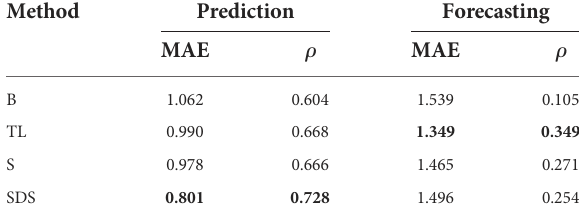
using the four methods: (B)aseline-GRU without personalisation, (T) ransfer (L)earning, (S)ubgroup models, and (S)ubject-(D)ependent (S)